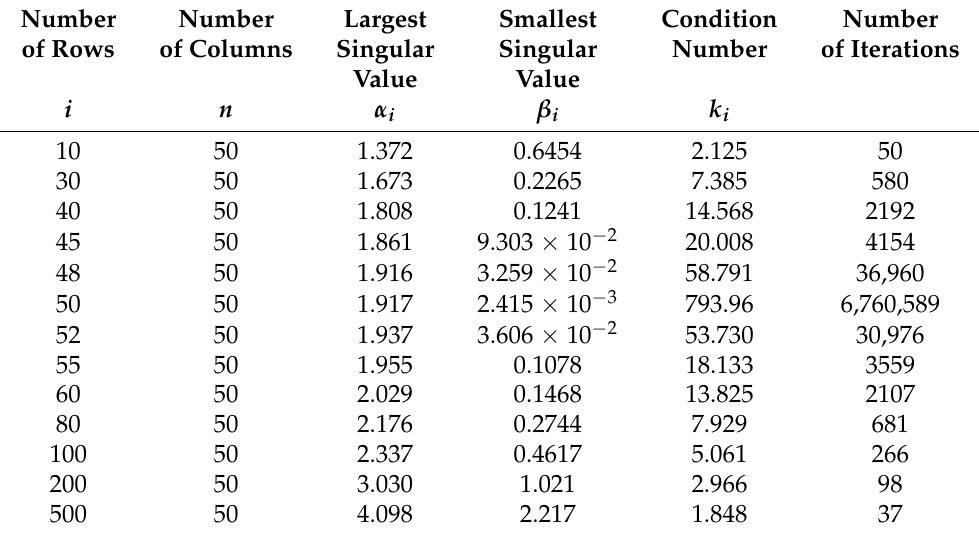
Table 12. Iterations anomaly in the methods of Richardson, Cimmino, and